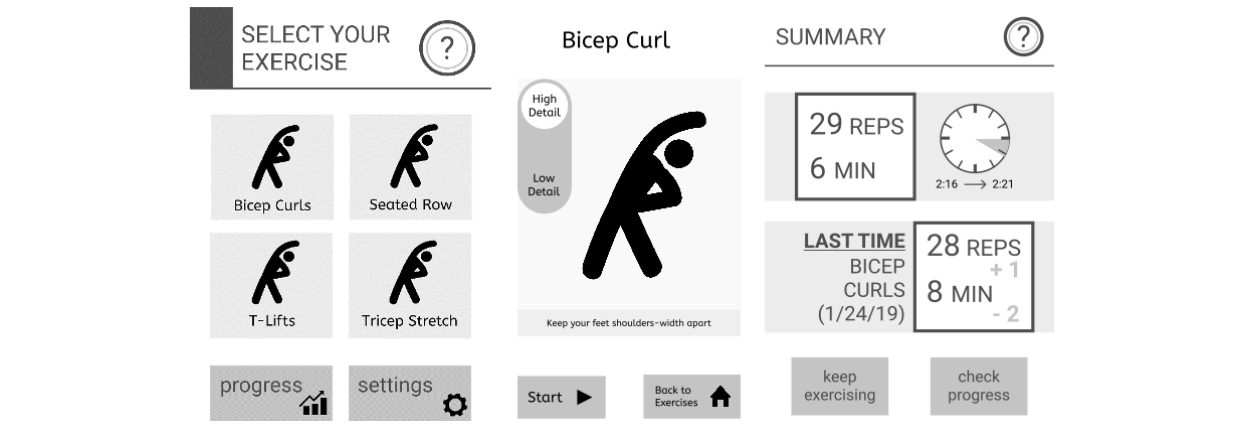
Figure 1. App versions for round 2 (round 1 did not use wireframes) consisted of black and white wireframes of the exercise selection screen and a preworkout screen.